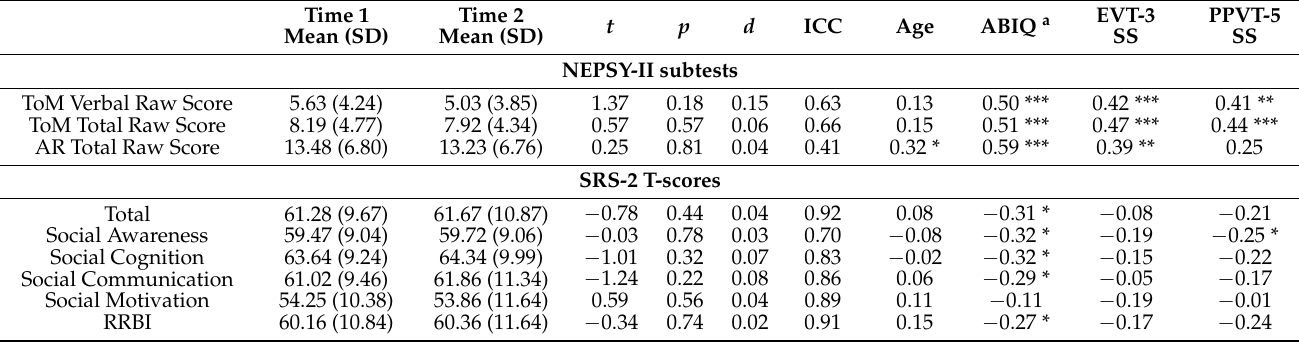
Table 2. Examination of practice effects, test-retest reliability, and correlations with broader developmental domains.